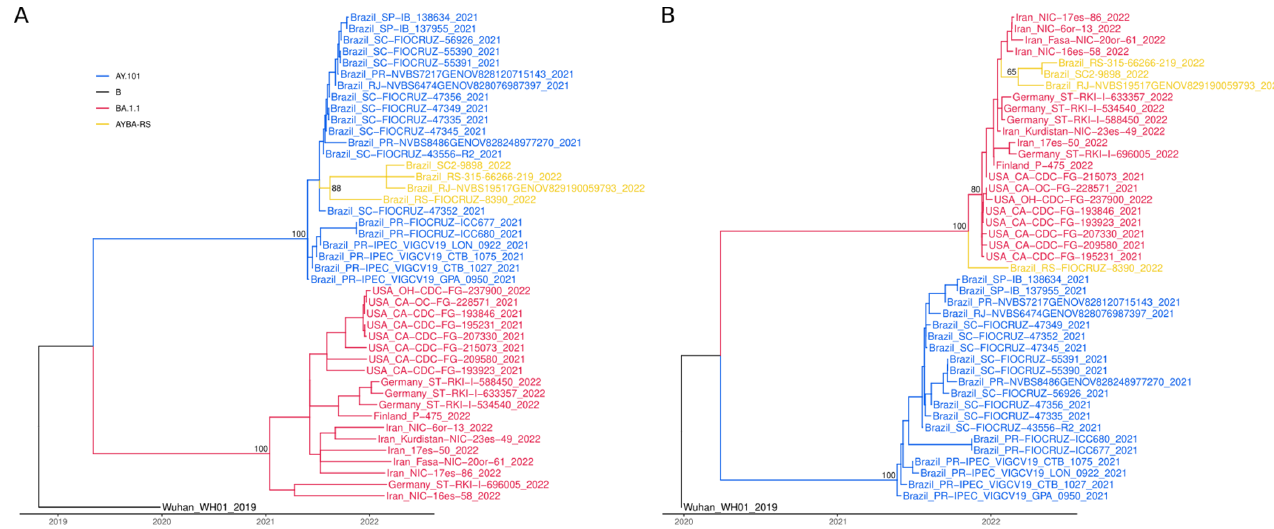
Figure A5. Phylogenetic history of genomic segments of the Brazilian Deltacron. ( A ) The 5’ segment (coordinates 1–21,769) of the Brazilian recombinant grouped to the Brazilian AY.101 genomes. ( B ) The 3’ segment (coordinates 21,770–29,903) of the Brazilian recombinant grouped to BA.1.1 genomes from diverse geographical locations. Ultrafast bootstrap values of the main branches are close to the nodes.